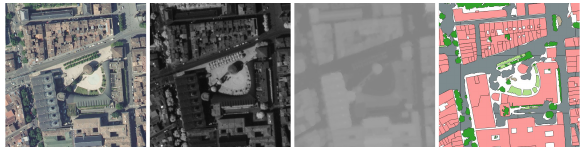
Figure 3. Example of input data (RGB, Infra-Red, DHM,